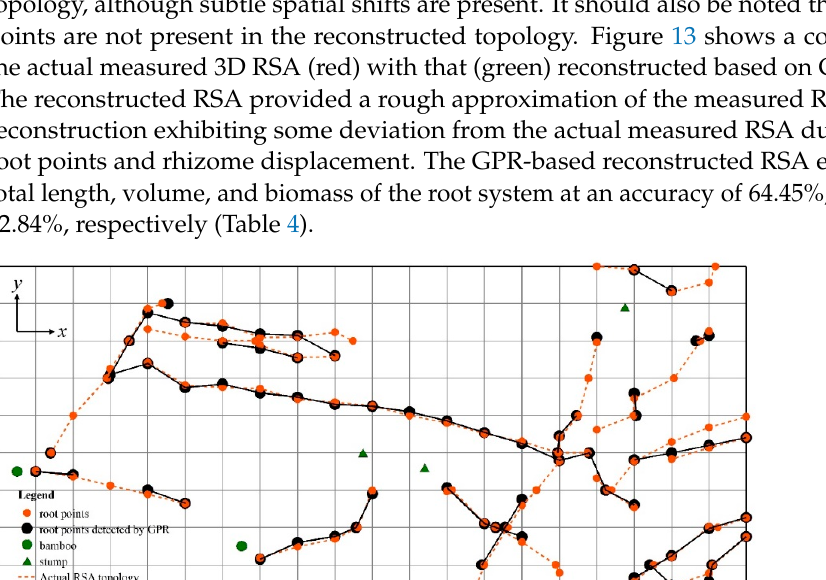
Figure 11. Front ( a ) and ground plan ( b ) views of the reconstructed 3D root system architecture (RSA) of moso bamboo. This 3D RSA was developed using the topology structure presented in Fig- ure 10.